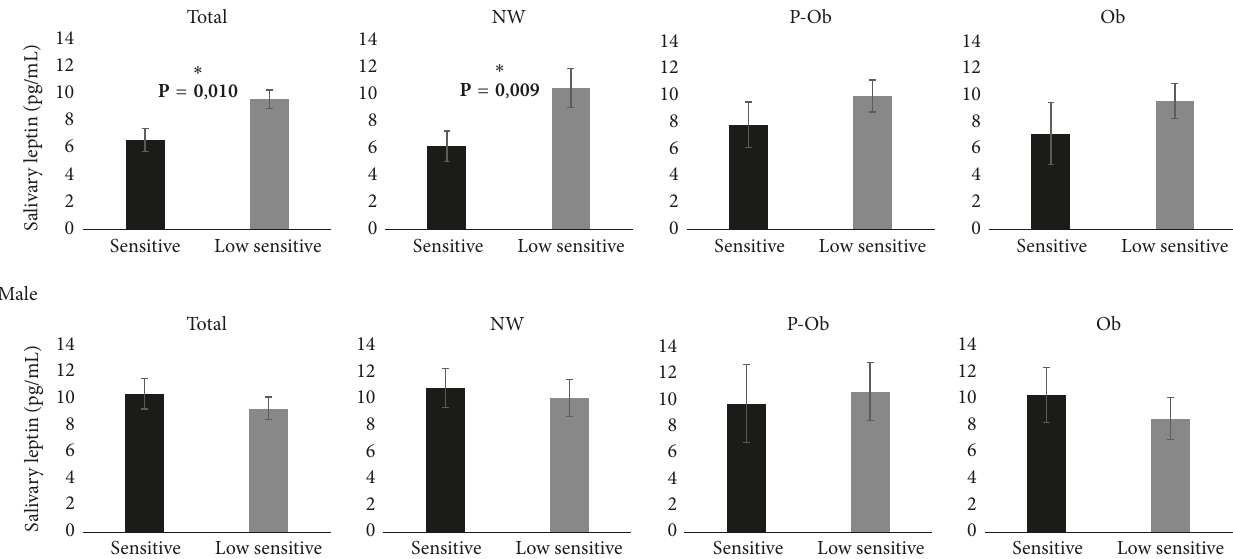
Figure 3: Salivary leptin levels in children with different sweet taste sensitivity [NW: normal weight ( 𝑁 = 30 girls and 34 boys); P-Ob: preobese ( 𝑁 = 16 girls and 15 boys); Ob: obese ( 𝑁 = 12 girls and 13